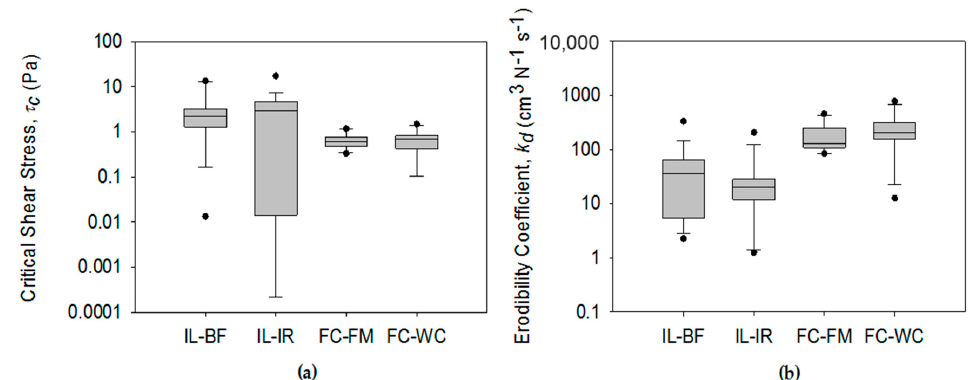
Figure 3. Variation of excess shear stress parameters measured using JETs along Barren Fork Creek (IL-BF), Illinois River (IL-IR), Fivemile Creek (FC-FM) and Willow Creek (FC-WC): ( a ) τ c ; and ( b ) k d .